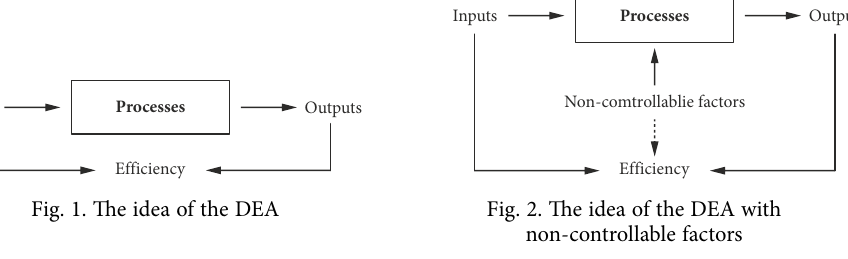
non-controllable factors